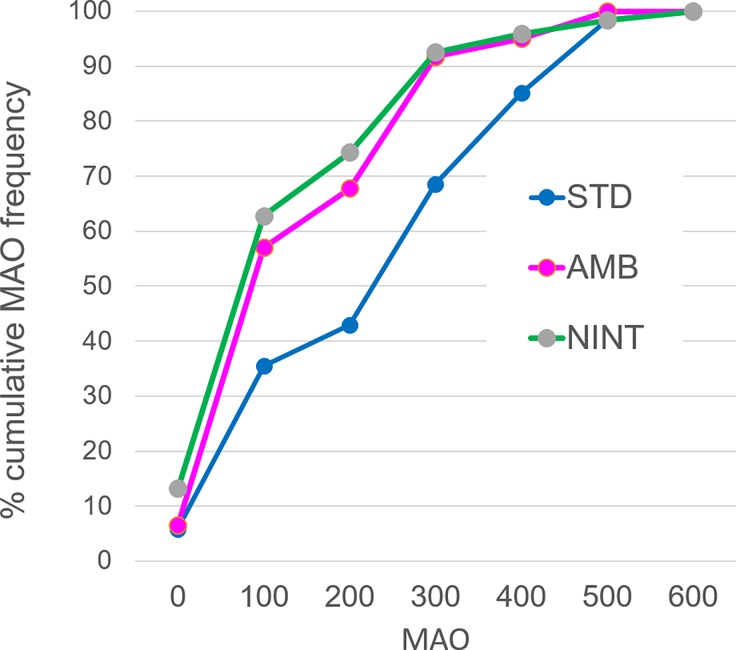
Cumulative distribution of MAO in the UGSTD, the UGAMB and the UGNINT.The vertical axis represents the percentage of responders whose MAO is the JPY shown on the horizontal axis or less.